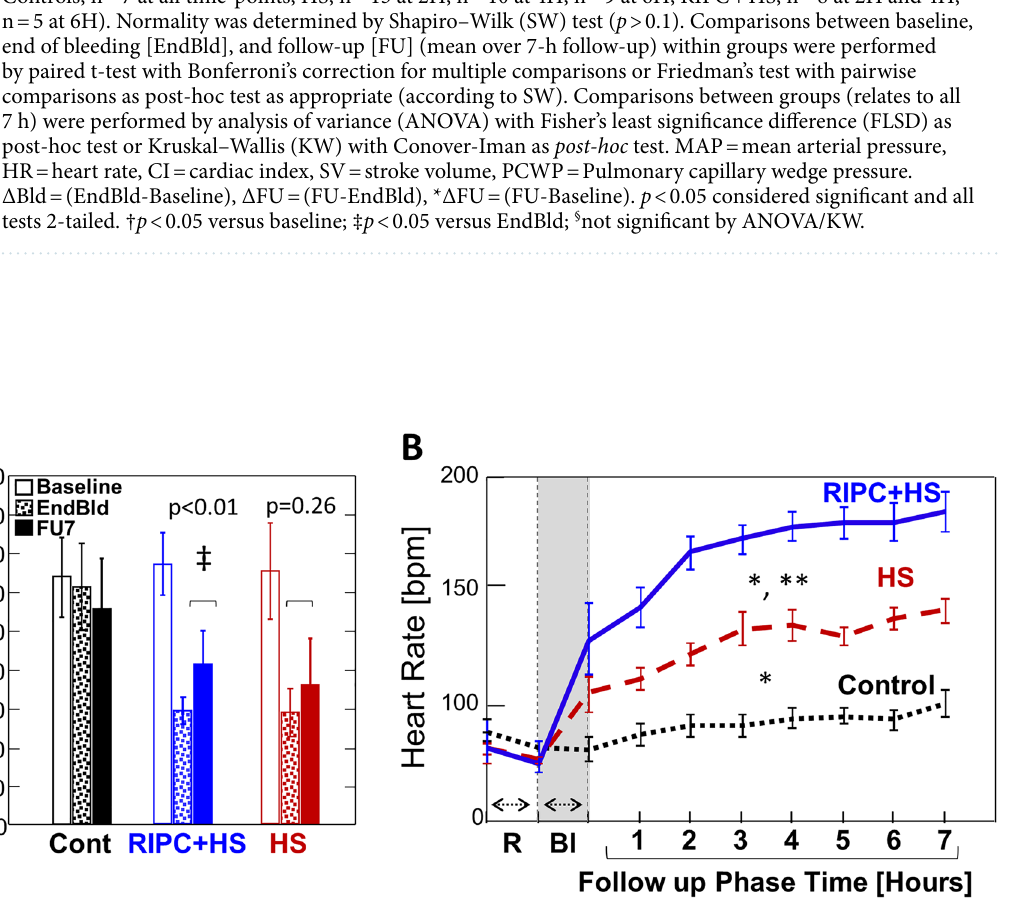
Figure 2. Hemodynamics: MAP and Heart Rate. ( A ) Mean Arterial Pressure (MAP) Compensation: Bars represent mean ± SD. Note significant increase in MAP in the follow-up period compared to the end of bleeding in animals with prior RIPC (RIPC + HS) but not in animals without RIPC (HS only). ‡ p < 0.05 by paired t-test with Bonferroni’s correction for multiple comparisons ( B ) Heart Rate (HR): Data points and error bars represent mean ± SEM. Note: animals of RIPC + HS group had greater compensation of HR after bleeding and during the follow-up period. R = time of RIPC, Bl = time of bleeding [grey rectangle]. p < 0.05 * versus Control; ** versus HS by ANOVA with FLSD as post-hoc test. #animals: Controls n = 7; HS n = 13; RIPC + HS n =